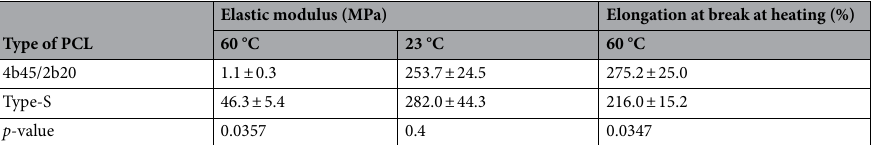
Table 1. Elastic modulus and elongation at break of the 4b45/2b20 and the commercially available mask (Type-S). PCL;